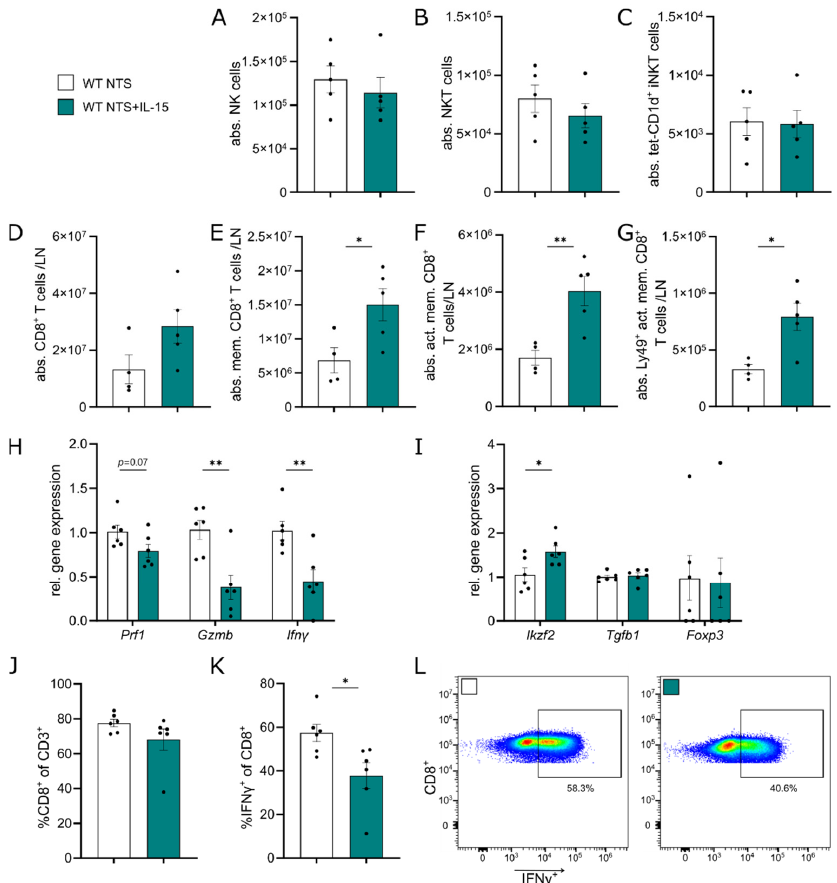
Figure 3. IL-15 increases CD44 + memory CD8 T cell numbers in the periphery and mitigates a